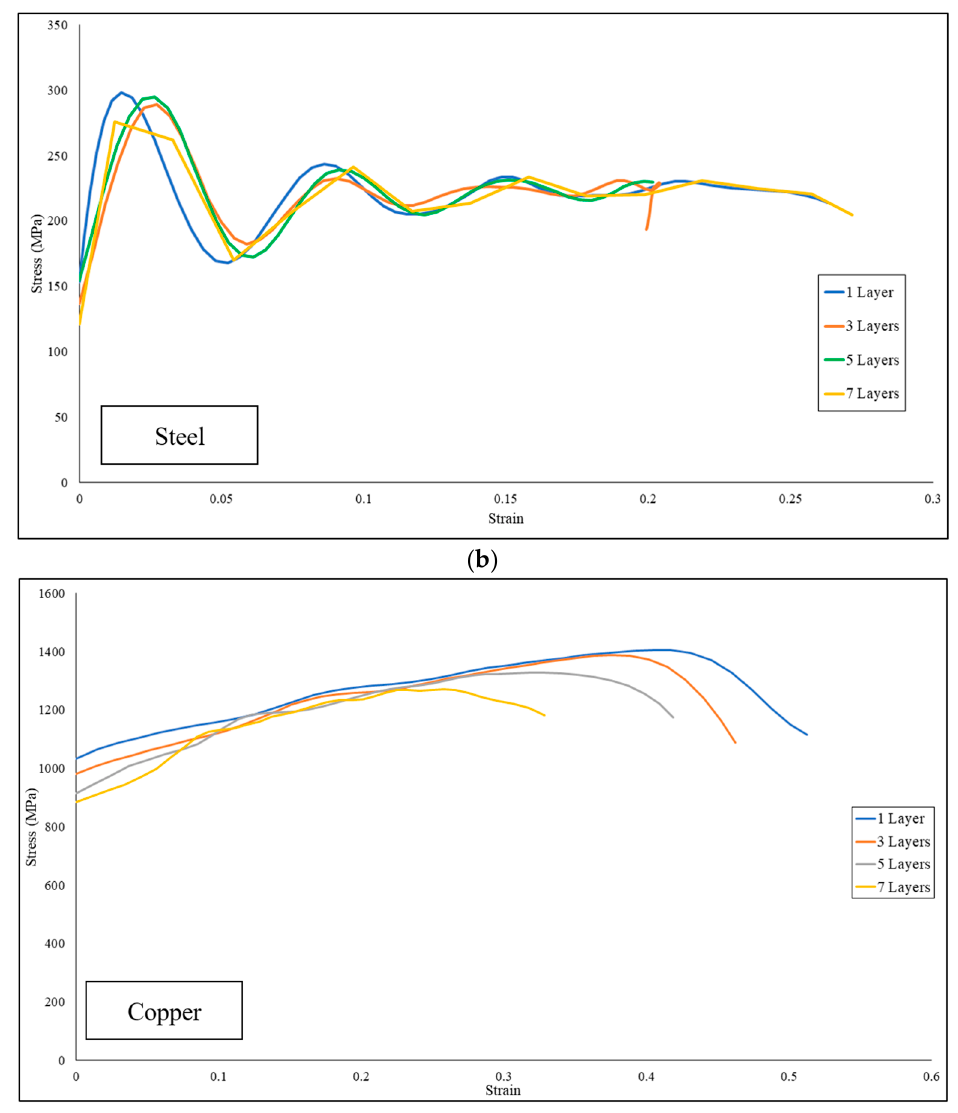
Figure 12. Variation of the stress due to the stacking on ( a ) aluminum, ( b ) steel, and ( c ) copper under a loading speed of 20 m/s.